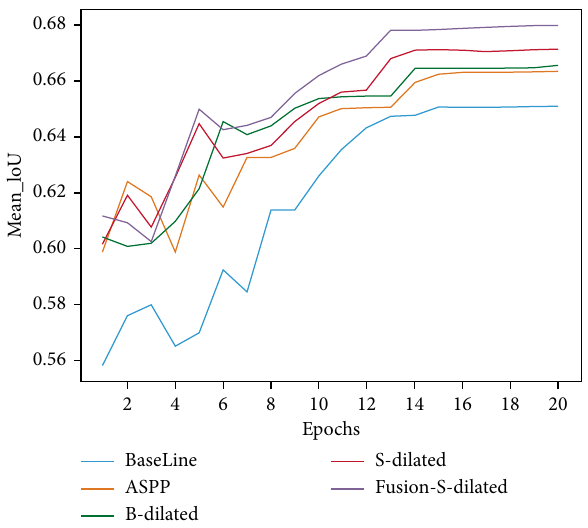
Figure 7: The curves of mIoU with different training stages.